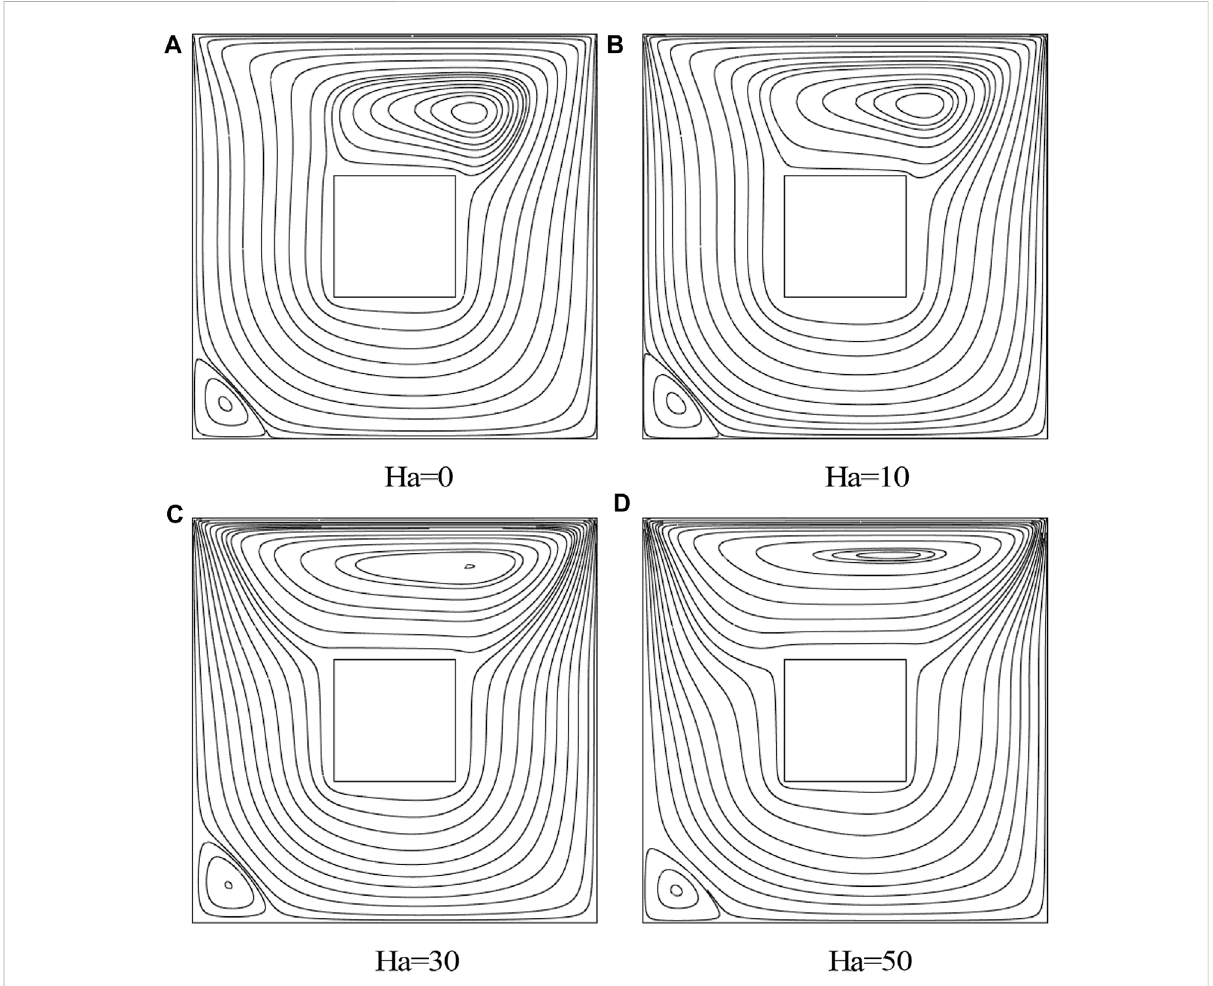
FIGURE 12 In fl uence of Gr on isotherms with a non-uniformly heated bottom wall: adiabatic cylinder with Ha (cid:2) 20 and Re (cid:2)